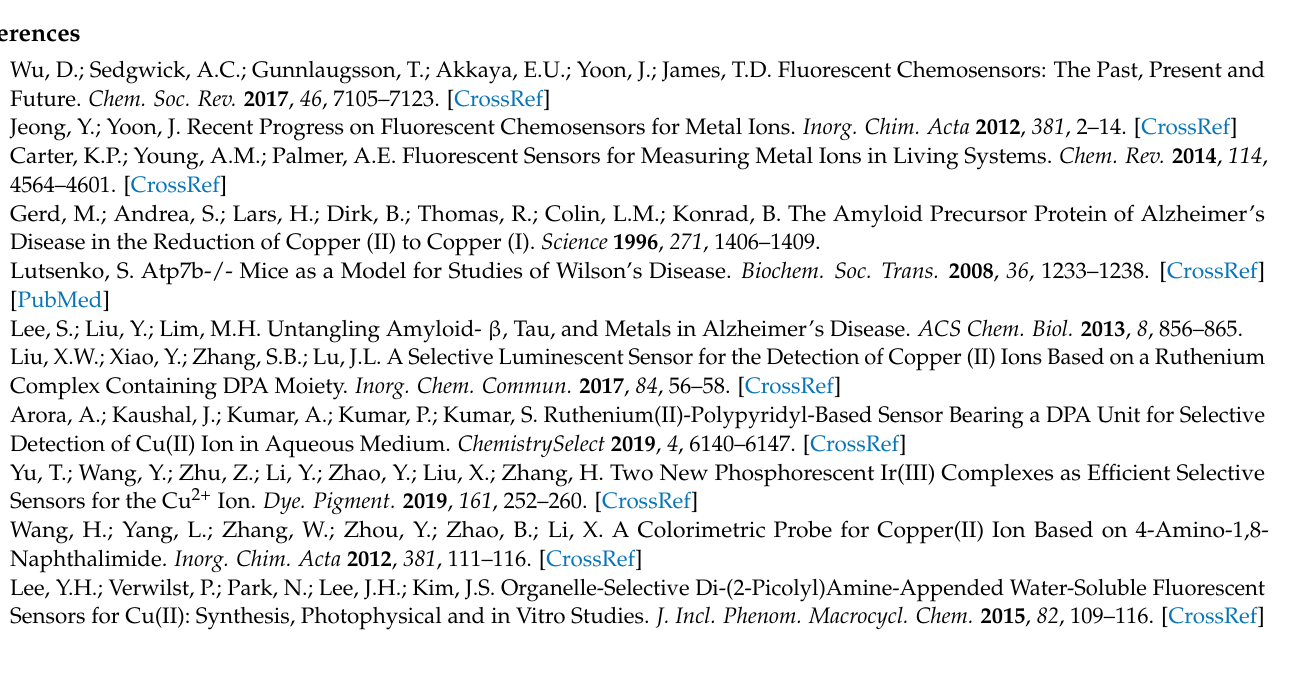
metal ions. Table S1: Full NMR peak assignment for chemosensor 4 . Table S2: Stokes shift from chemosensor 4 in different organic solvents, and their corresponding empirical polarity